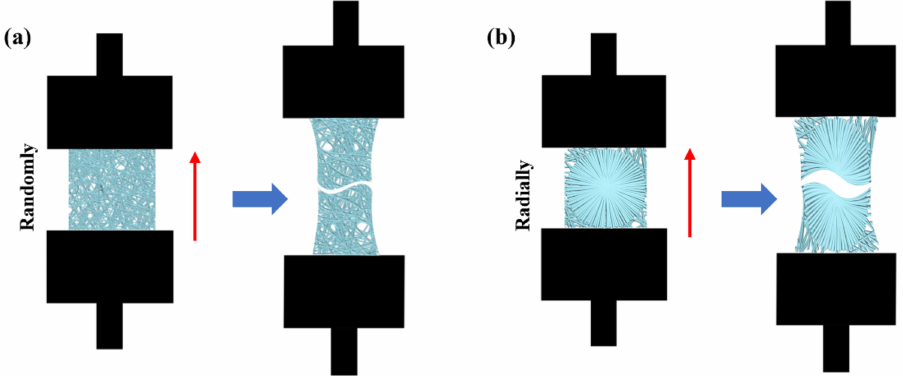
Figure 2. Schematic of tensile test: ( a ) randomly oriented nanofiber scaffolds; ( b ) radially oriented nanofiber